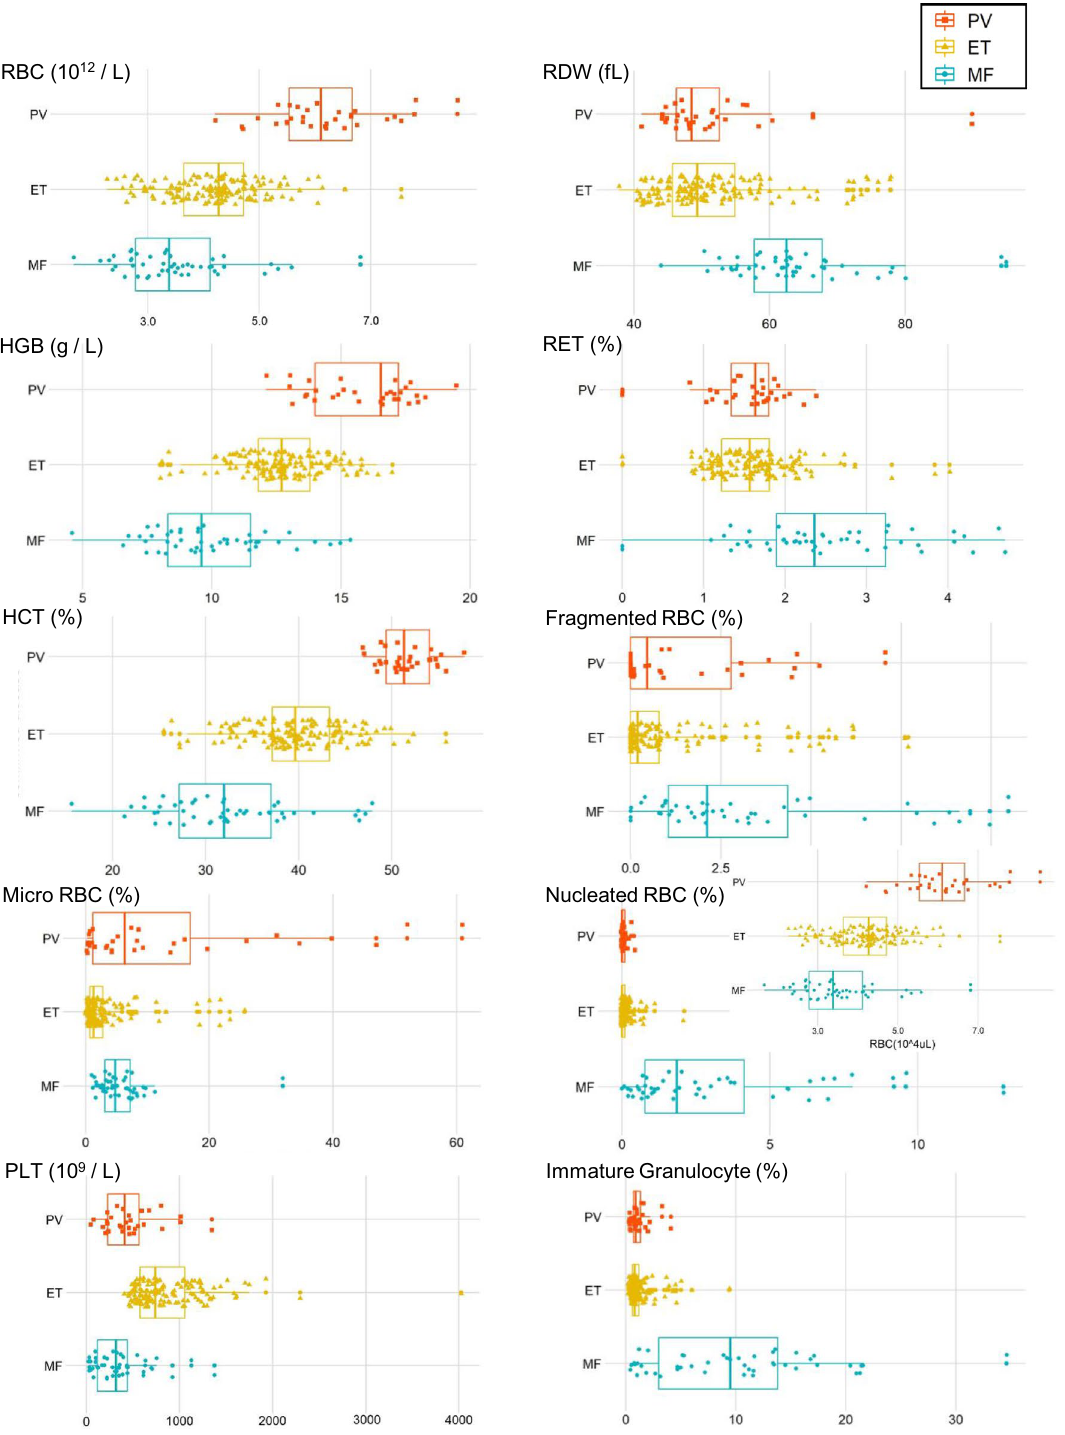
Figure 2. CBC and research parameters in differentiating Ph-negative MPNs extracted from the XN-9000. The box plots s how the essential raw data for each case of PV, ET, and